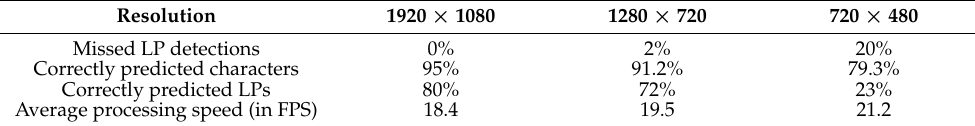
Figure 15. Evolution of the percentage of correctly recognized license plates and inference speed (in frames per second) in Video 1, with respect to the maximum number of frames used for voting. Table 11. Car and license plate recognition results per different resolutions of Video